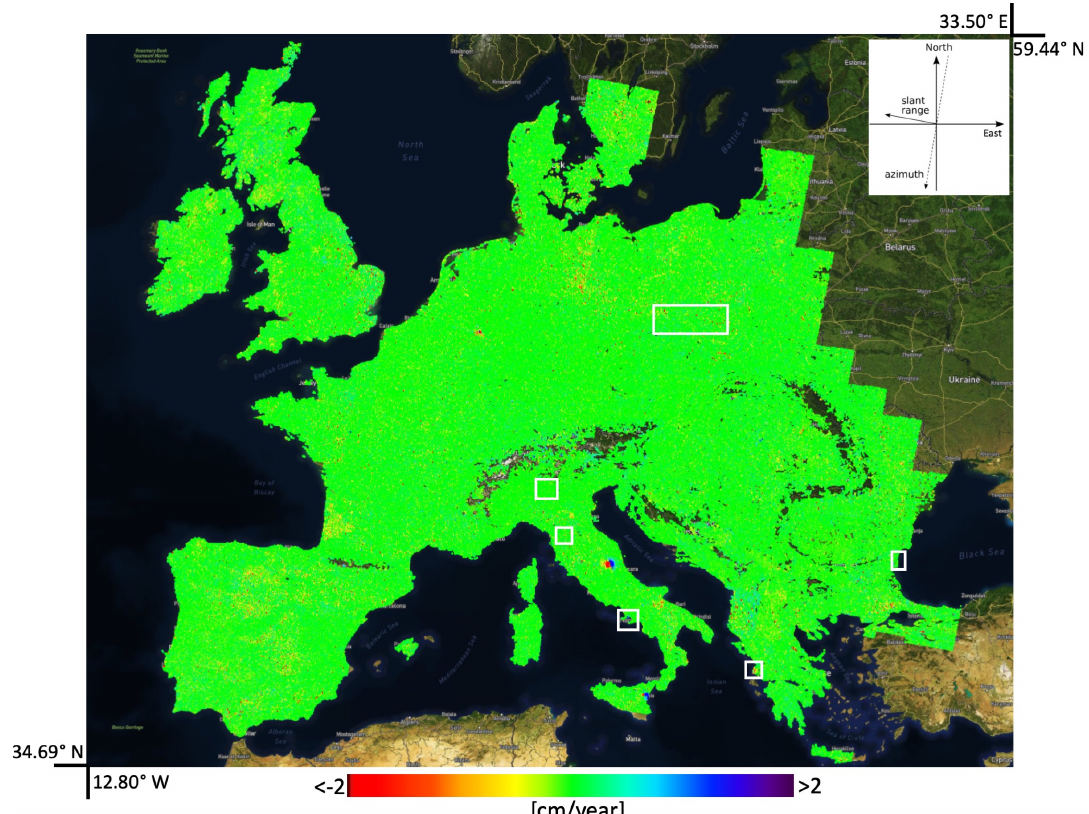
Figure 12. Mosaicking of the LOS mean deformation velocity maps (cm / year), geocoded and superimposed on an optical image of Europe (Mapbox Satellite Streets source). The white rectangles identify the zoom-in areas that are analyzed in more details in the following. Note that the red color corresponds to a sensor-target range increase, while the blue one to a sensor-target range decrease. The inset in the upper right corner reports the SAR sensor azimuth / range and the North / East directions.